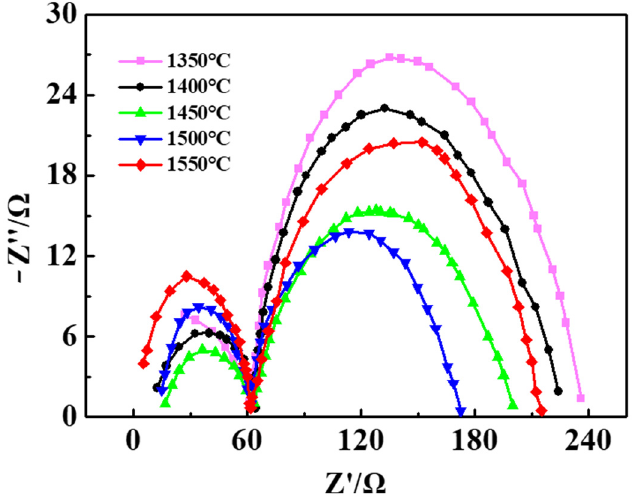
Figure 9. AC impedance spectrums of the Pt/YSZ electrodes sintered at different temperatures tested at 750 °C.